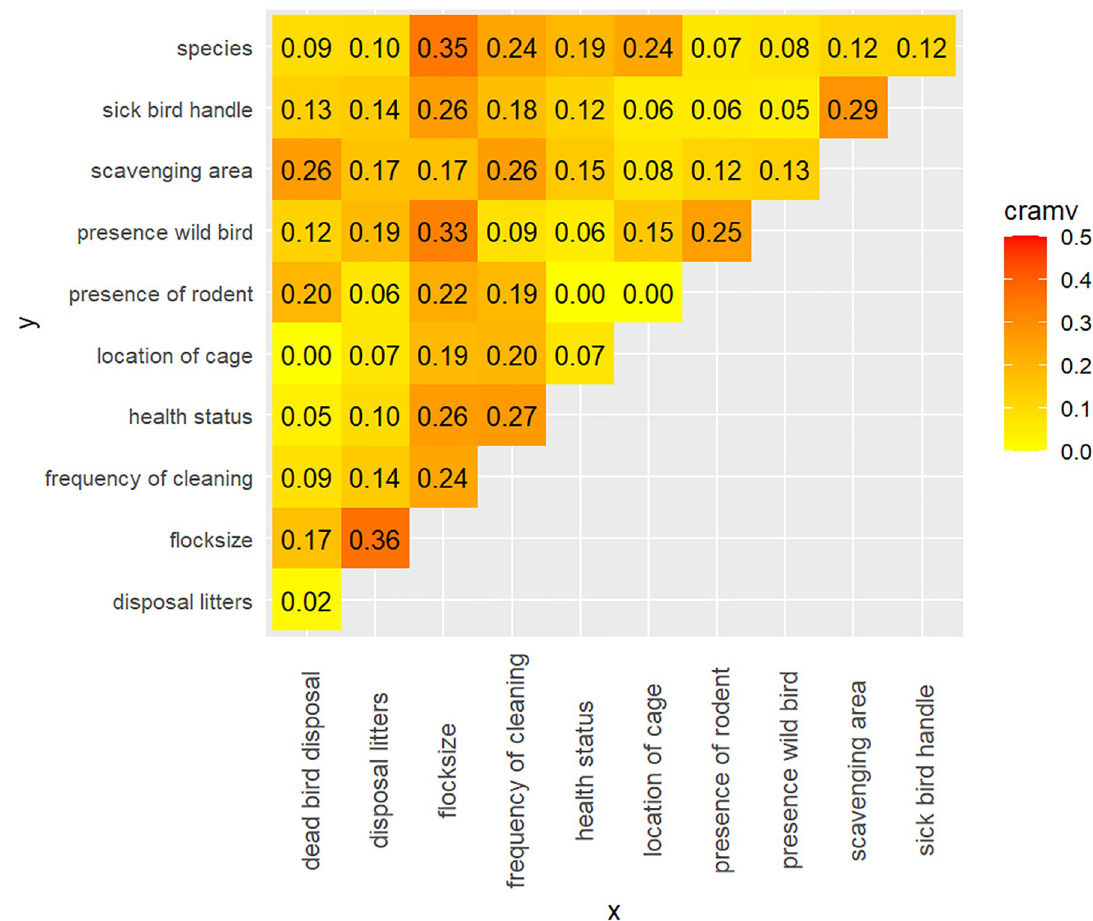
Fig 3. Association between the predictor variables using a matrix of Cramer’s V